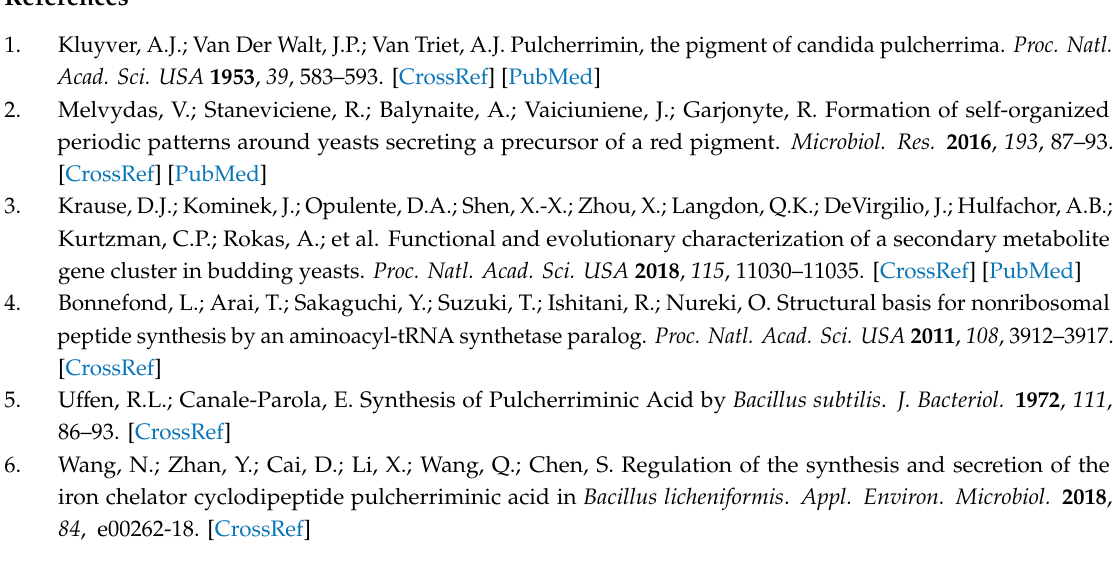
Figure 2. Pulcherrimin production by yeast strains in the culture media. Values show the mean ± standard deviation (SD, n = 3). Results obtained for minimal media were compared with those for YPD cultures. Values with different letters are statistically different; a: p ≥ 0.05; b: 0.005 < p < 0.05; c: p < 0.005.